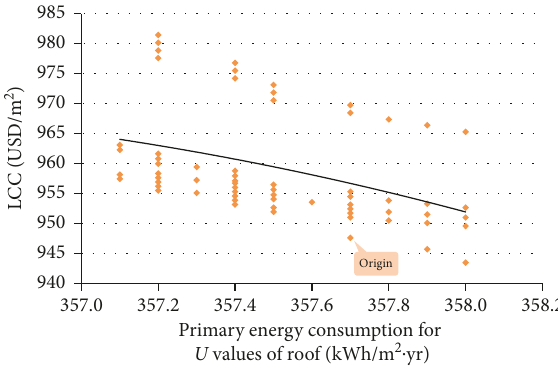
Figure 3: Primary energy use according to the U values for the floors of the target building.